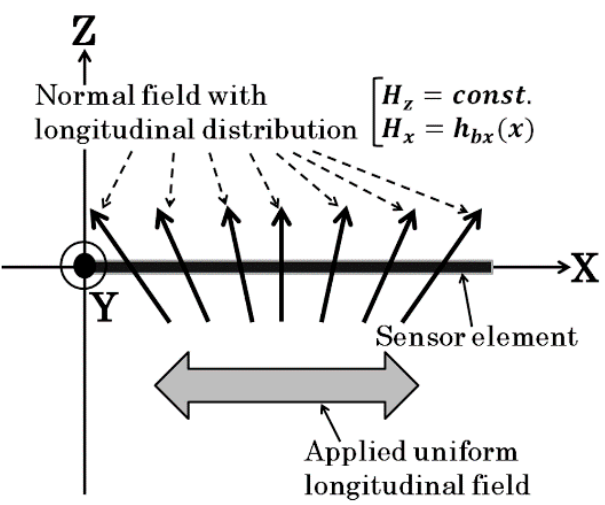
Figure 15. Schematic explanation of a distributed vertical magnetic field [21].